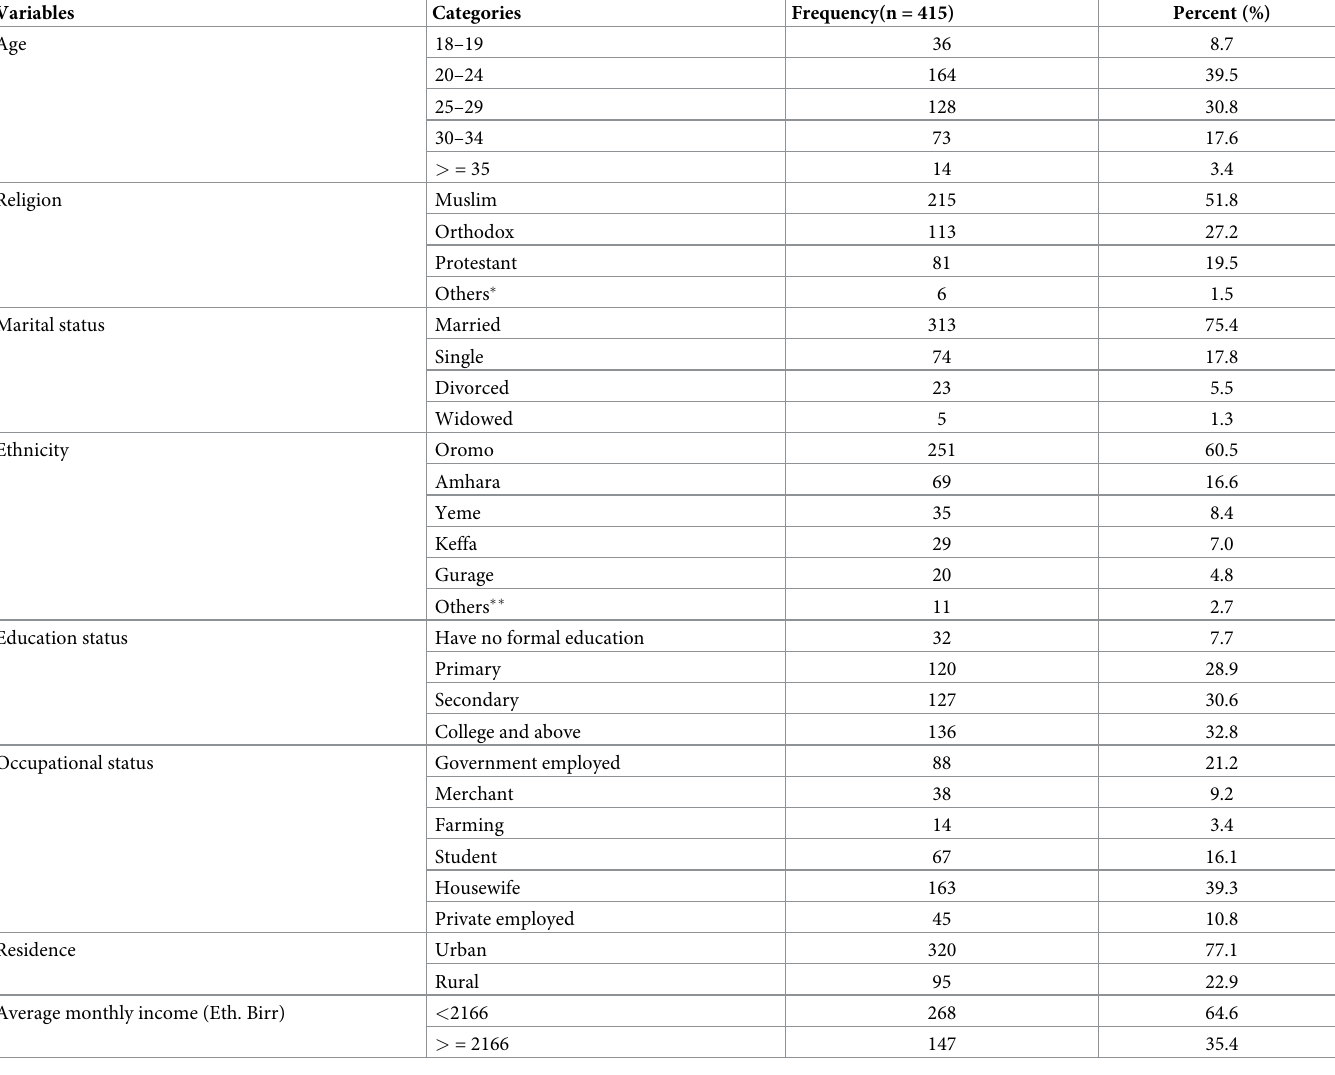
Table 1. Socio-demographic characteristics of pregnant women attending antenatal care at Jimma medical center, Jimma, Southwest Ethiopia, 2020 (N =